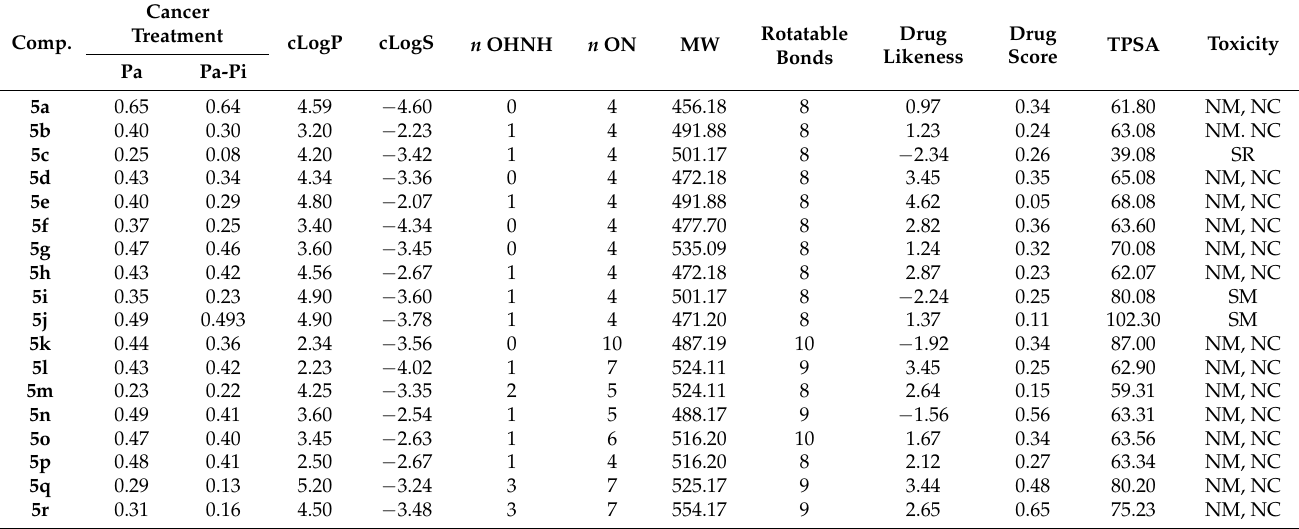
Table 3. The predicted toxicity risks of all the synthesized derivatives were envisaged by Osiris Property Explorer and are given in Table 3. The compounds, except for 5c , 5i , and 5j , were found to be non-mutagenic and non-carcinogenic. PASS prediction was performed for the synthesized compounds to omit the compounds with a probability of activity (Pa) < 0.400 [42,43]. The remaining compounds were selected for evaluation based on the net probability of activity over inactivity (Pa-Pi), being more than 0.400 (Table 3). Table 3. In silico physicochemical properties for oral bioavailability and bioactivity of the test compounds using computational predictive